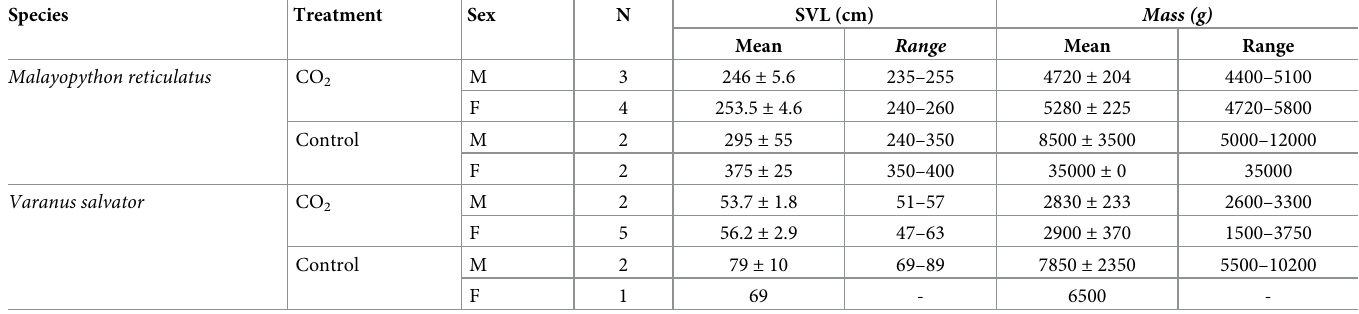
Table 2. Means, standard errors and ranges for snout-vent length (SVL) and body mass for reptile specimens used to examine plasma corticosterone responses to